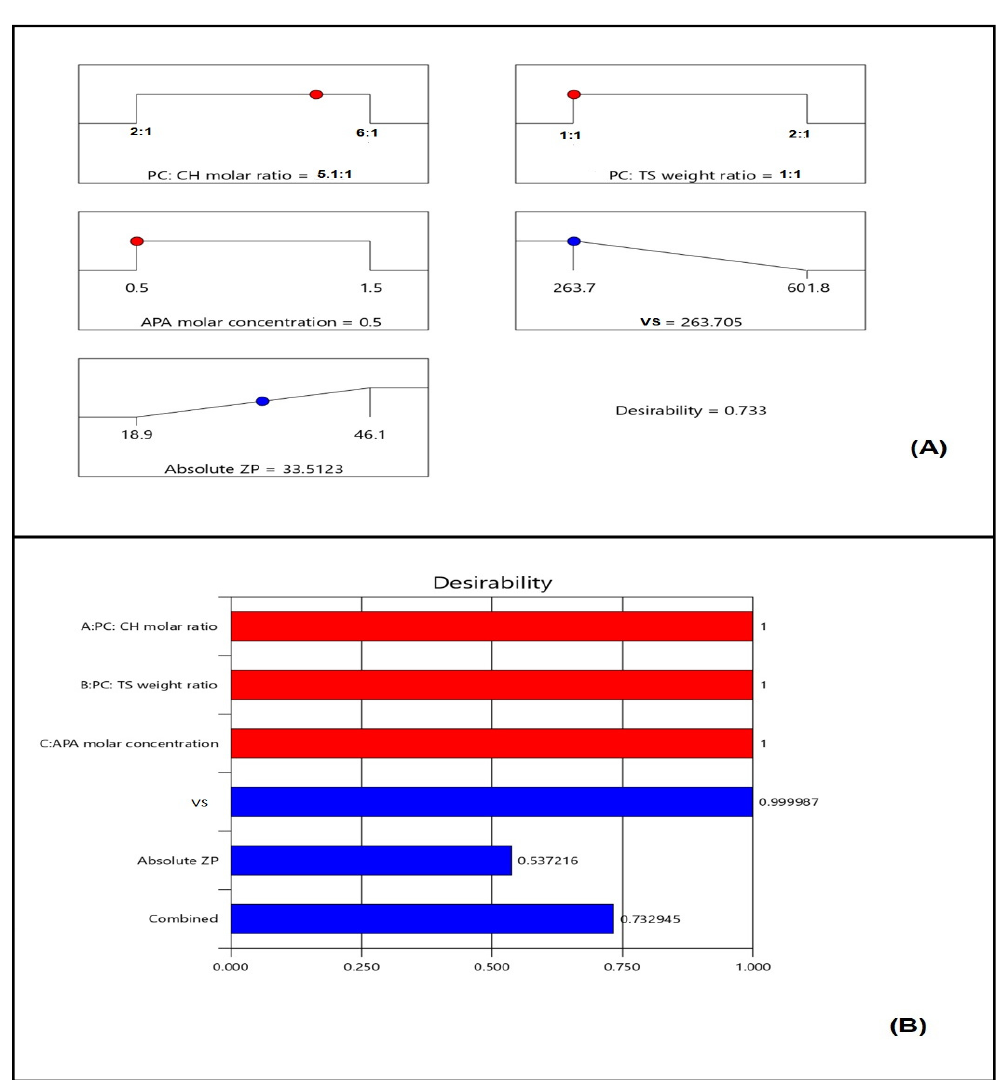
Figure 6. ( A ) Ramp graphs representing the optimized levels of the independent variables and the predicted responses for the optimized EGA-EML-APA (Red points represent the optimized levels of variables and blue points represent predicted response); ( B ) desirability values for the predicted responses and overall desirability of the optimized ICA tochozeinolate nanospheres. Abbreviations: EGA, ellagic acid; EML, emulsomes; APA, apamin; PC: Phospholipon 90 G; Cholesterol: CH; TS; Tristearin. Red points represent the optimized levels of variables and blue points represent predicted response.